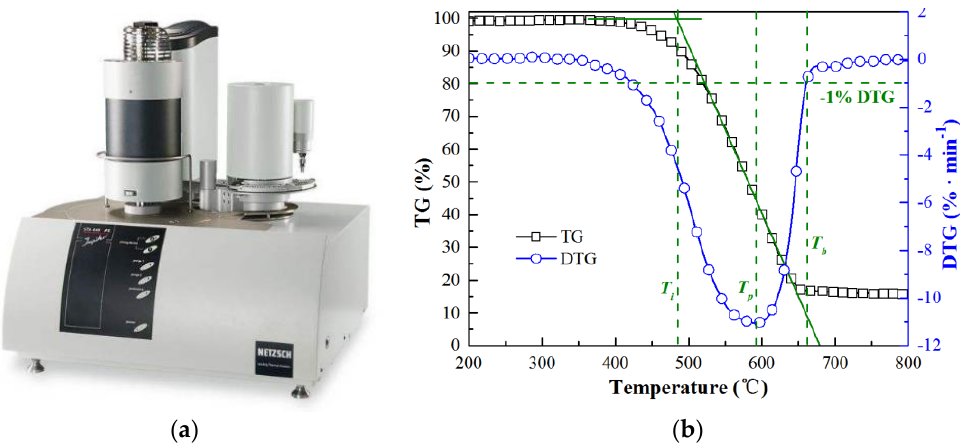
Figure 1. ( a ) Netzsch thermogravimetric analyzer; ( b ) the ignition and burnout temperatures. According to thermo-gravimetric analysis curves, there are several methods that are used to determine the ignition and burnout temperatures. They are usually slightly different for different methods. In this study, the ignition temperature T i is obtained according to the TG-DTG curve method (as shown in Figure 1b) [21]. A tangent line on the TG curve is taken as the peak temperature T p corresponding to the maximum weight loss rate on the FTG curve, and the temperature at the intersection of the tangent line and the initial horizontal line of the reaction on the TG curve is the ignition temperature T i . The burnout temperature T b is defined as the temperature at which the combustion rate ex- ceeds −1 (wt, %/min) at the end of a major combustion process. More details are shown in Figure 1.